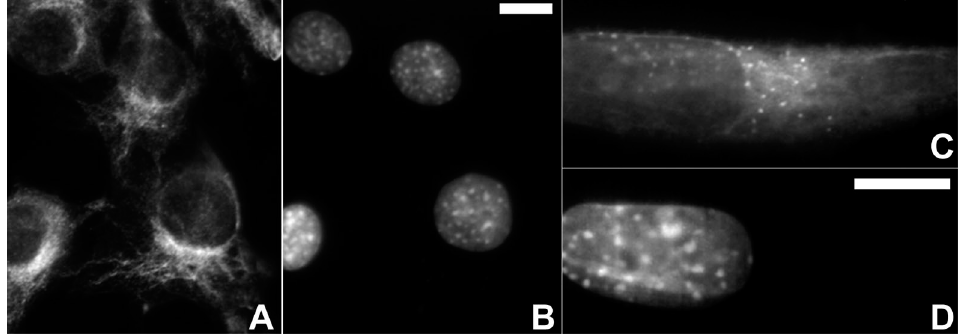
Figure 3. Fluorescence microscopy of C2C12 cells grown in the absence of EGTA (control cells, A and B) or in the presence of 1.75 mM EGTA for 24 h (C and D). Cells were stained with anti-desmin antibody (A and C) and with the nuclear probe DAPI (B and D). Desmin is present as a dense network of filaments in control cells (A), as opposed to fragmented filaments and dots observed in EGTA-treated cells (C). Bar in B corresponds to 10 µm and bar in D corresponds to 5 µm.